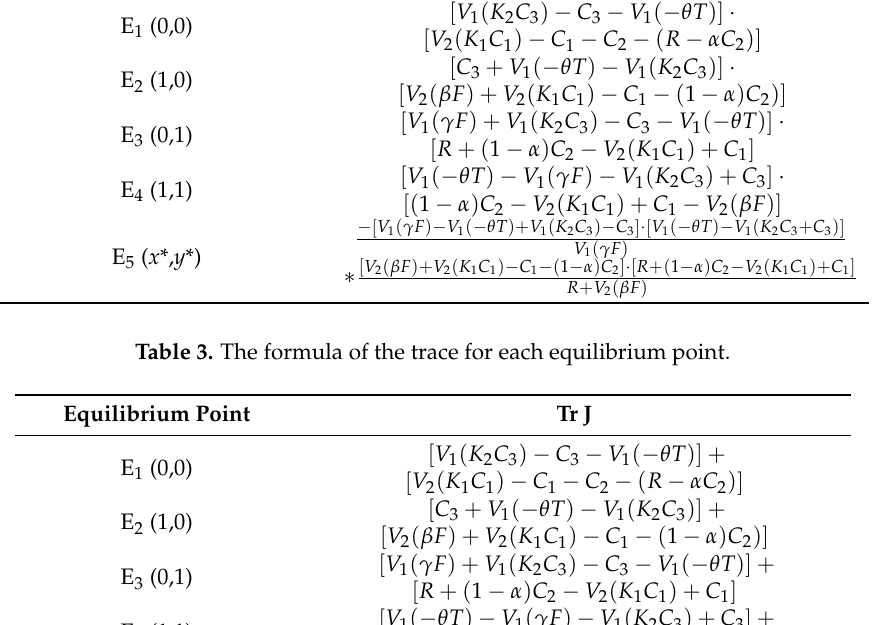
Table 2. The formula of the determinant for each equilibrium point. Equilibrium Point